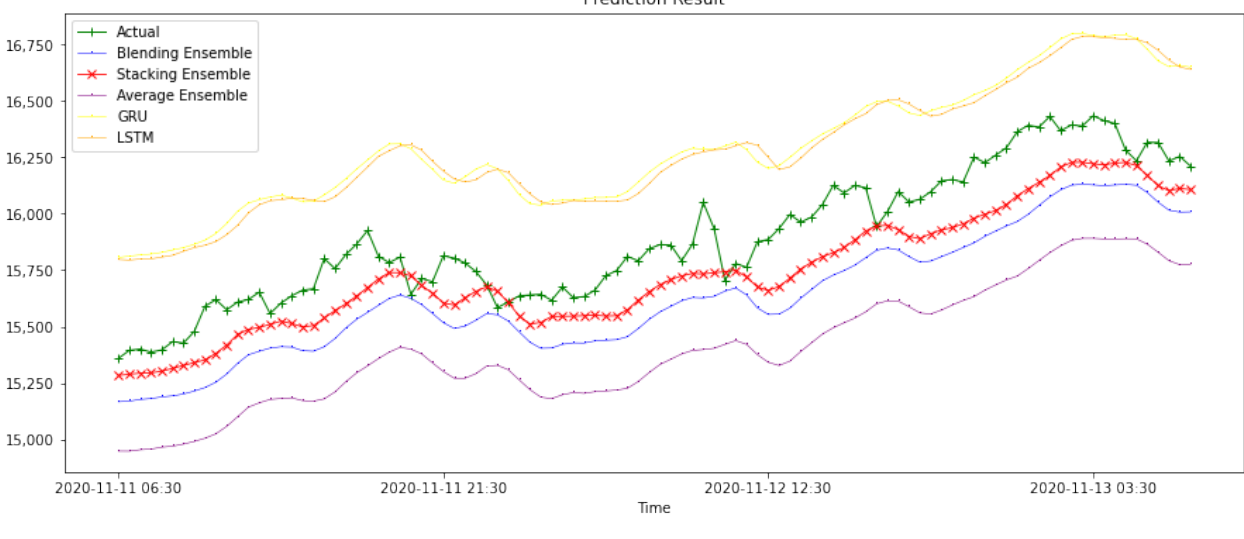
Figure 10. Price + technical indicator + sentiment indicator prediction results of the models from